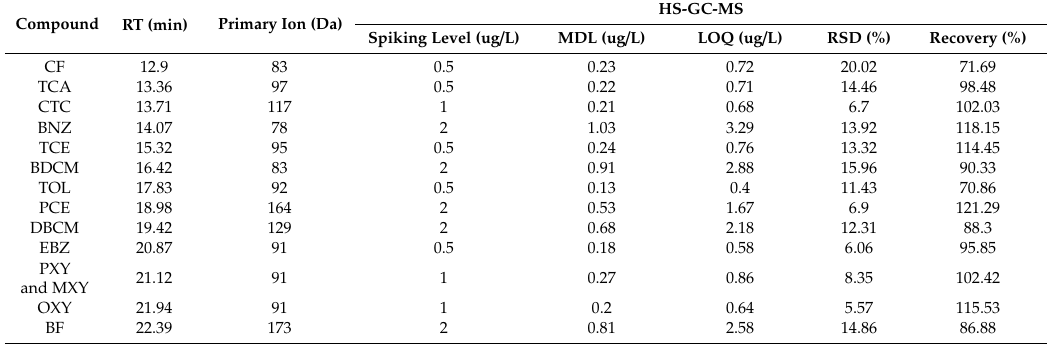
Table 3. Retention time (RT) and selected reaction monitoring transition of HS-GC-MS for 14